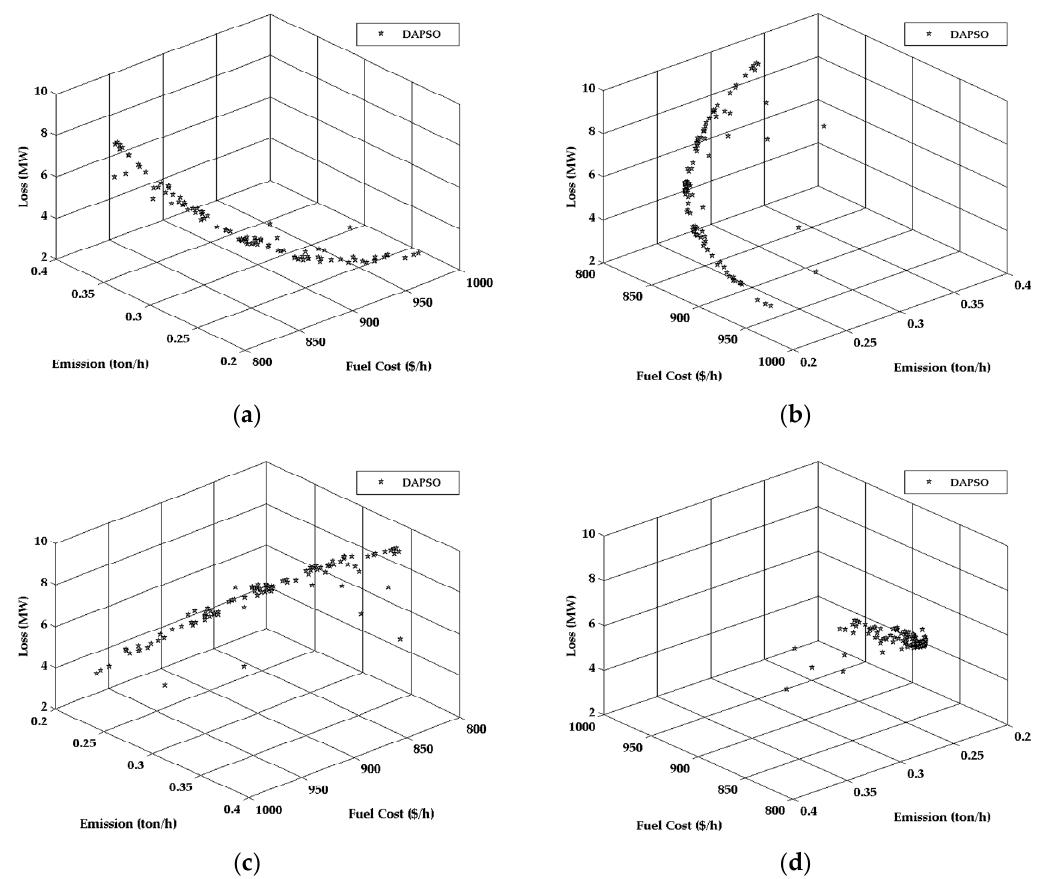
Figure 5. Three-dimensional Pareto fronts when considering fuel cost, emissions, and transmission losses as part of the objective function for the IEEE 30-bus system shown in the different views: ( a ) front view; ( b ) side view; ( c ) back view; ( d ) side view